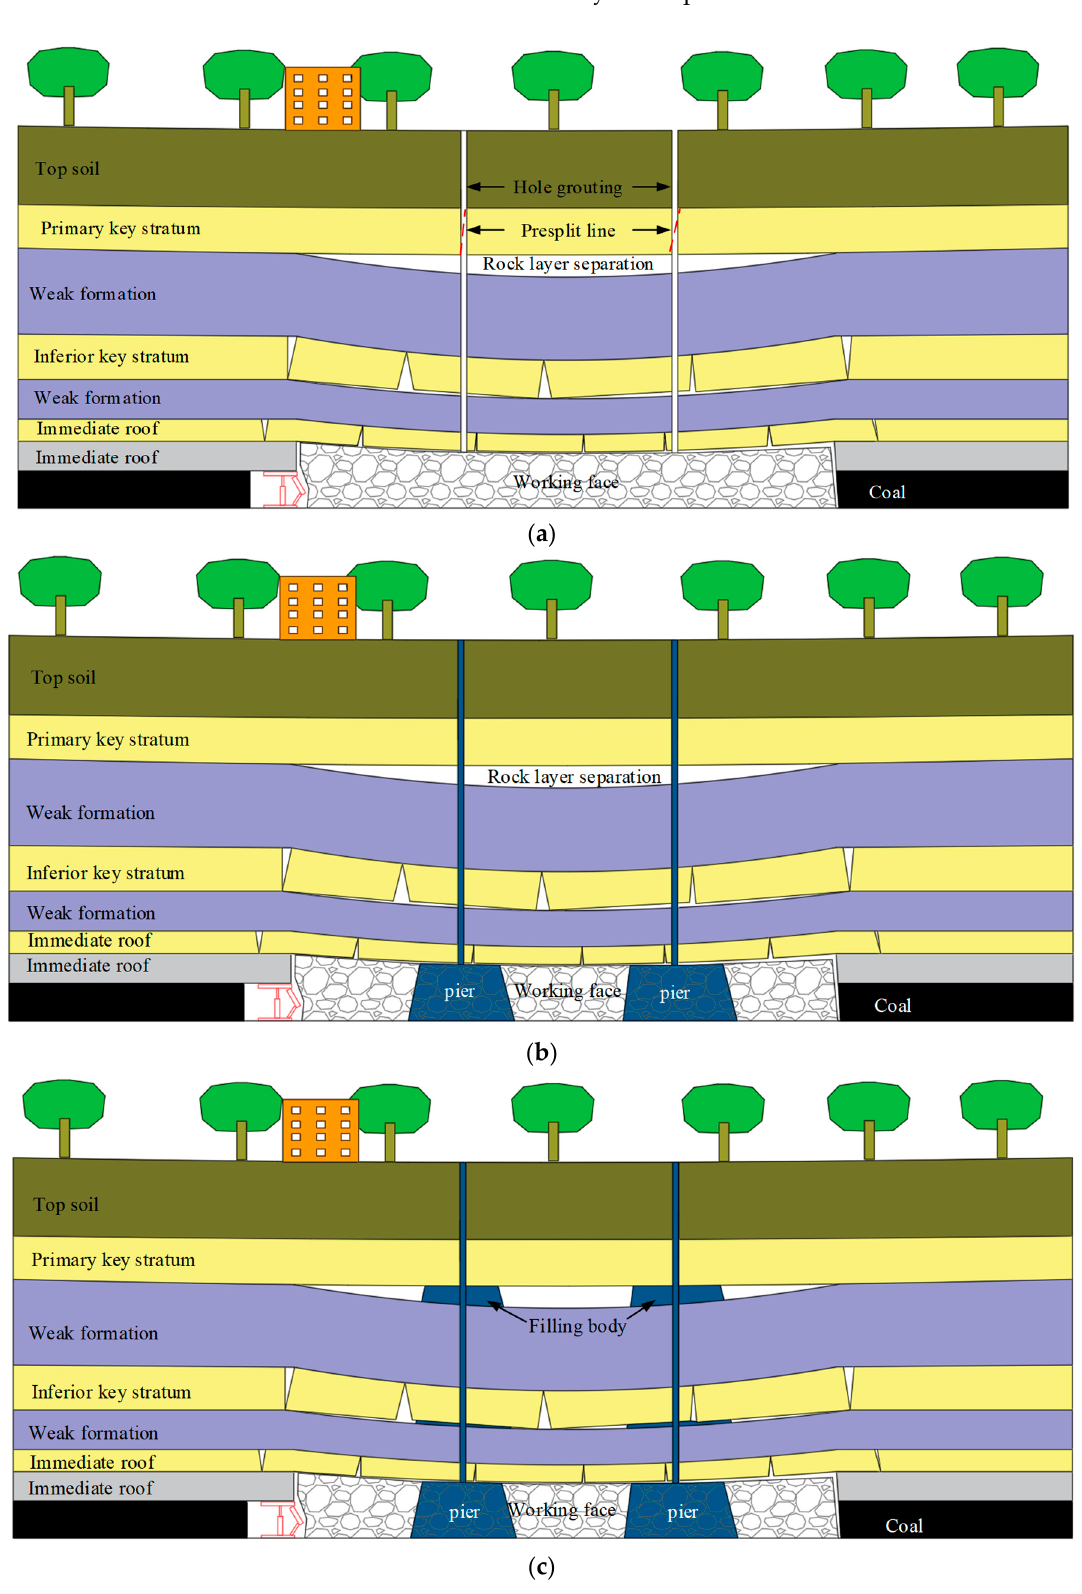
“separation layer filling body + key stratum + backfilling pier-column + coal pillar” joint medium to maintain the surface layer and prevent new subsidence in the surface layer.